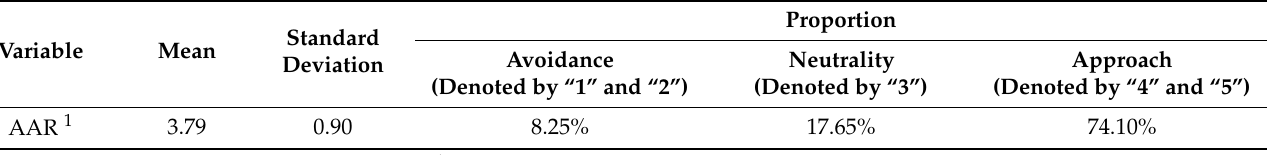
Table 2. Descriptive statistics of the approach–avoidance responses to personal carbon trading.